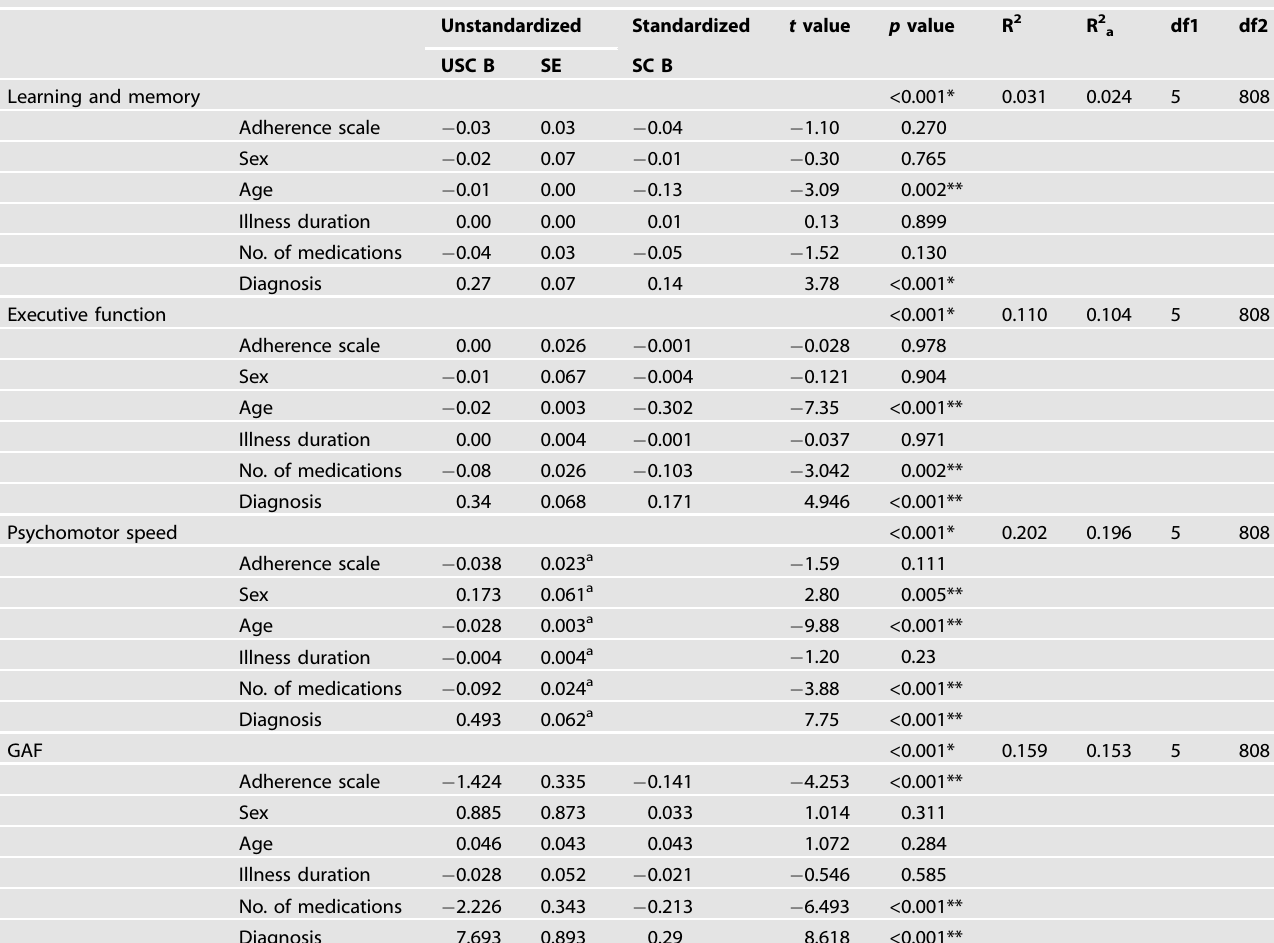
Table 2. Multiple linear regression analyses in the whole sample of patients with schizophrenia-spectrum and bipolar disorders, with cognitive performance as the dependent variable and adherence behavior, sex, age, duration of illness, number of prescribed medications, and diagnosis as the predictors. Patients with schizophrenia-spectrum and bipolar